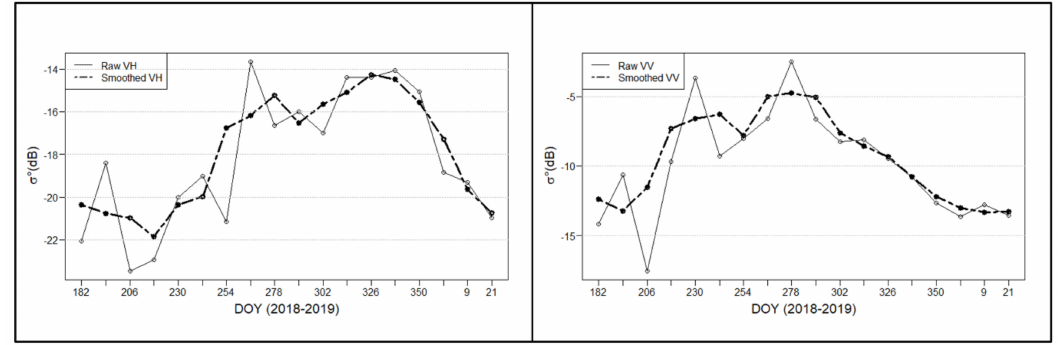
Figure 4. Raw and smoothed 2018 VH (left) and VV (right) backscatter temporal dynamics for a pixel (Lat. − 15.5669, Lon. 12.6794) of a paddy rice plot in Samiron valley. VH—vertical transmit–horizontal receive; VV—vertical transmit–vertical